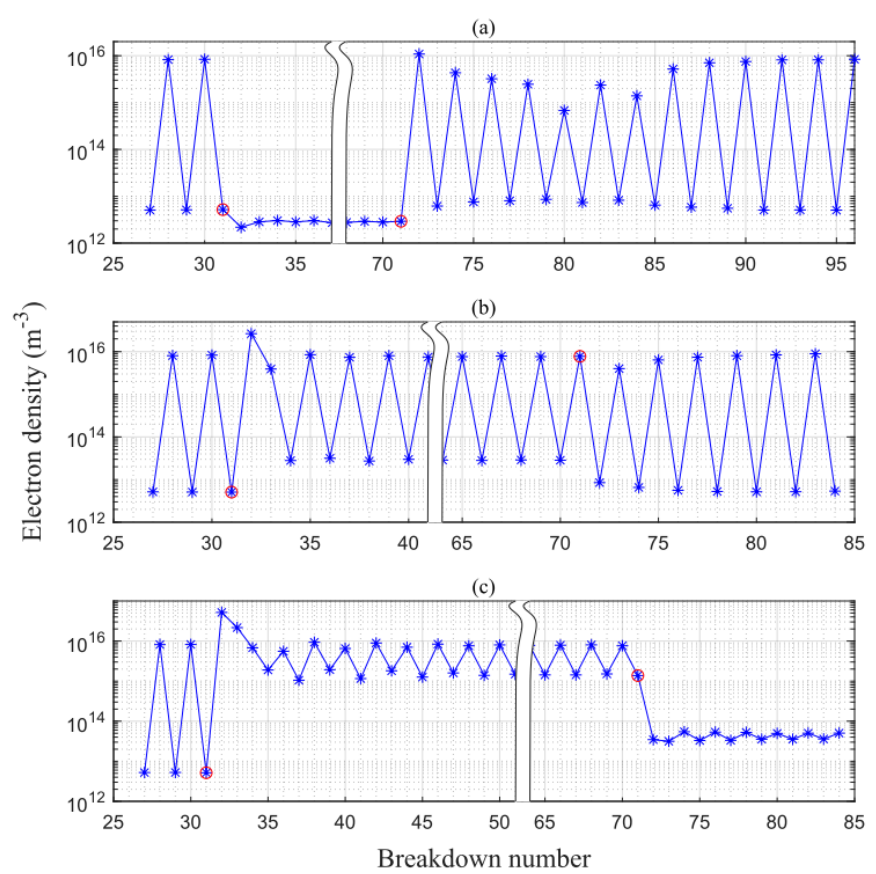
Figure 5. Evolution of the seed electron level as a function of the breakdown number, i.e., the average electron density right at the beginning moment of each breakdown. The f c in ( a – c ) are 8 kHz, 20 kHz, 30 kHz, respectively. The red circles indicate the transition points of the driving frequency.